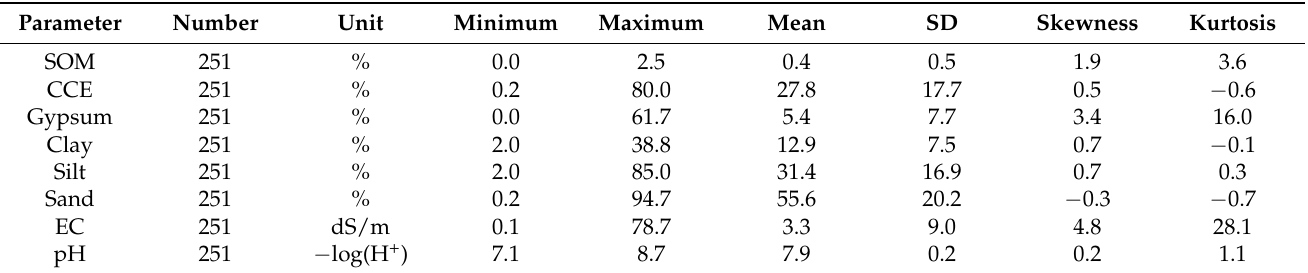
Table 2. Summary statistics of soil